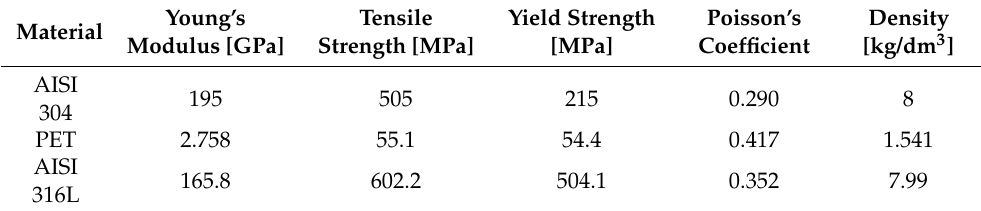
Table 3. Main properties of the adopted materials for the finite element analysis. The values re- ported for the AISI 304 and PET are those suggested by the Autodesk Inventor 2019 software, while for the AISI 316L the typical average values evaluated after the SLM printing process [44] have been accordingly added.